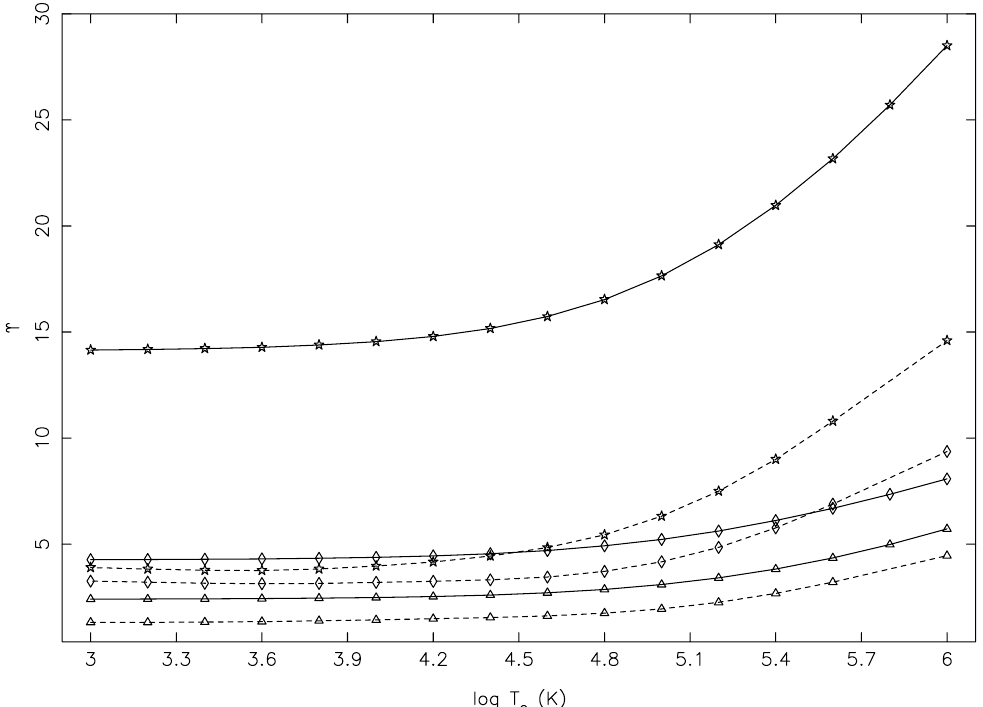
Figure 10. Comparison of FAC and BSR values of Υ for the 13–32 (triangles: 3p3d 1 D o (diamonds: 3p3d 3 P o –3p4p 3 D 1 ), and 22–33 (stars: 3p4s 3 P o 1